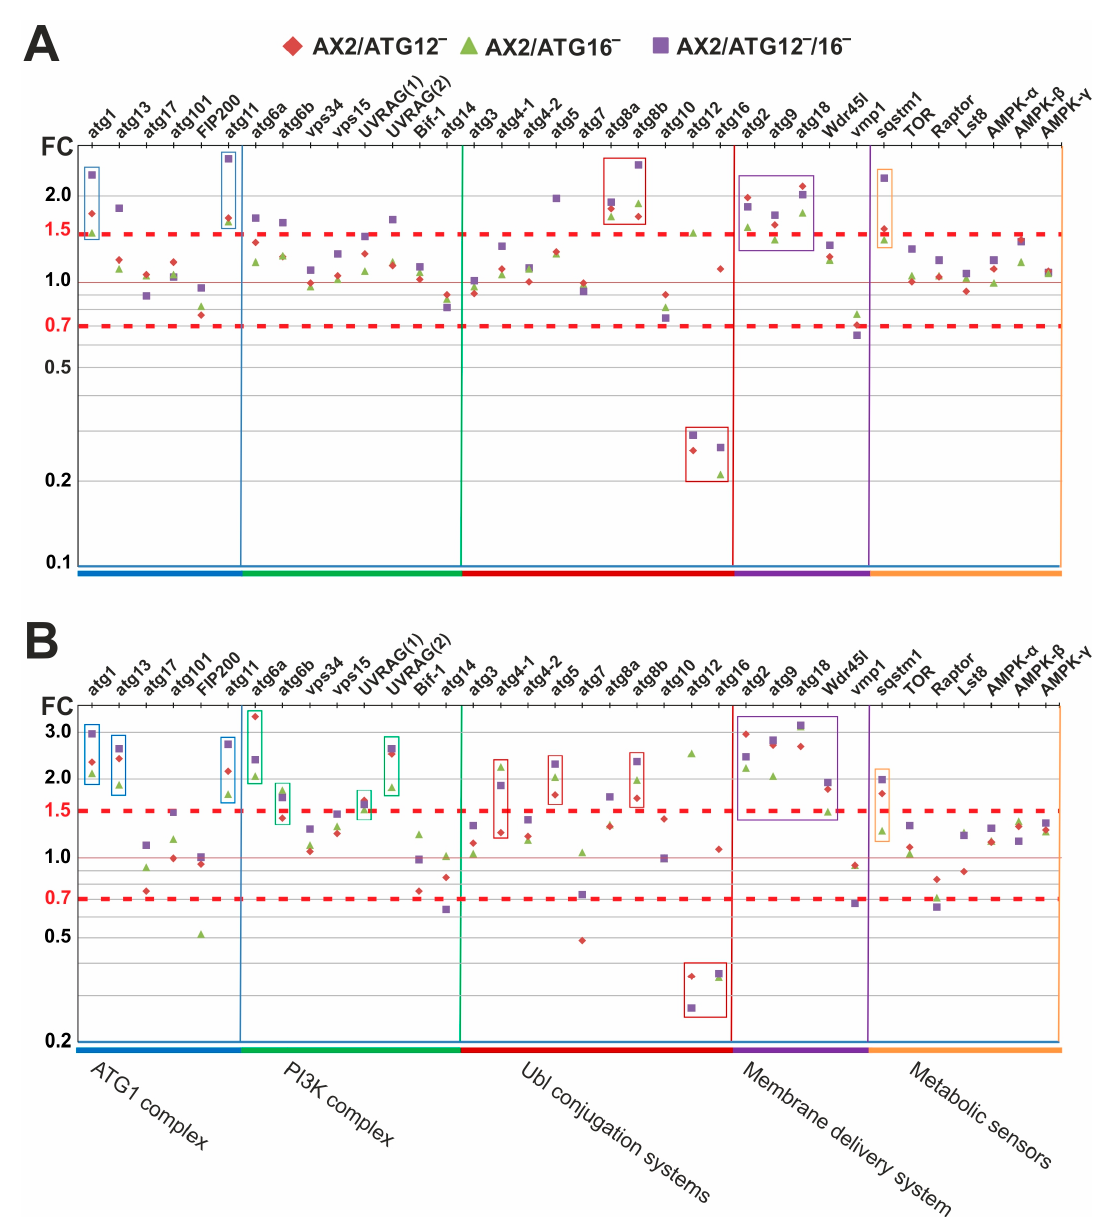
Figure 5. A subset of autophagy-related genes is up-regulated in ATG12 − , ATG16 − , and ATG12 − /16 − cells. ( A ) RNA from vegetative cells was isolated and RNA seq analysis was performed. All autophagy-related genes identified so far were assigned to functional categories. The threshold for up- and down-regulated genes was set to FC ≥ 1.5 or FC ≤ 0.7 and p ≤ 0.05. Six biological replicates of each strain were analyzed. ( B ) Upon starvation the up-regulation of several autophagy-related genes is more pronounced in ATG12 − , ATG16 − , and ATG12 − /16 − cells. RNA from cells that were starved for 3 h (t3) was isolated and RNA seq analysis was performed. Three biological replicates of each strain were